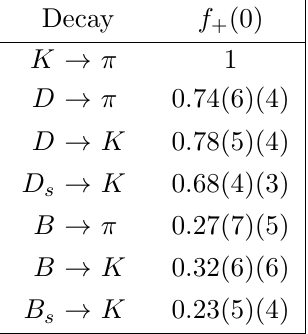
Table 1 . Form factors f + (0) extracted from [57] for K , D and B